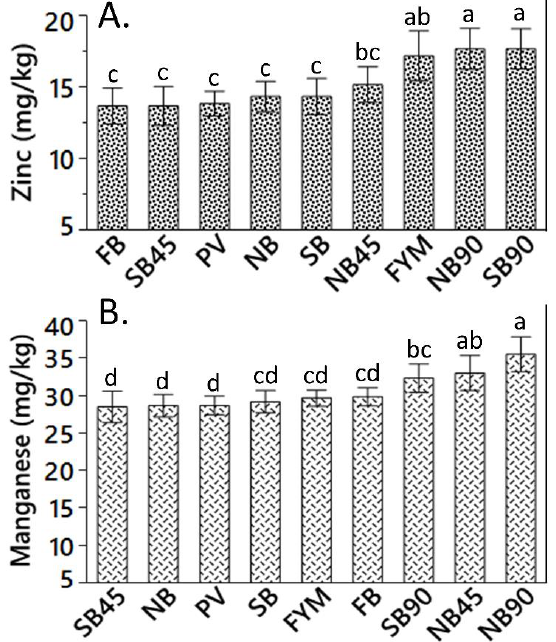
Figure 4. Total zinc ( A ) and manganese ( B ) dynamics in wheat grain after 84 years of the Crop Residue Long-term Experiment (CR-LTE) in Adams, OR. NB = No burn, SB = spring burn, FB = fall burn, FYM = farmyard manure, and PV = pea vine. 0, 45, 90 accompanied by NB, SB, and FB represents rates of N applied at 0 kg ha − 1 , 45 kg ha − 1 , and 90 kg ha − 1 , respectively. Means sharing the same letter are not significantly different ( p > 0.05).